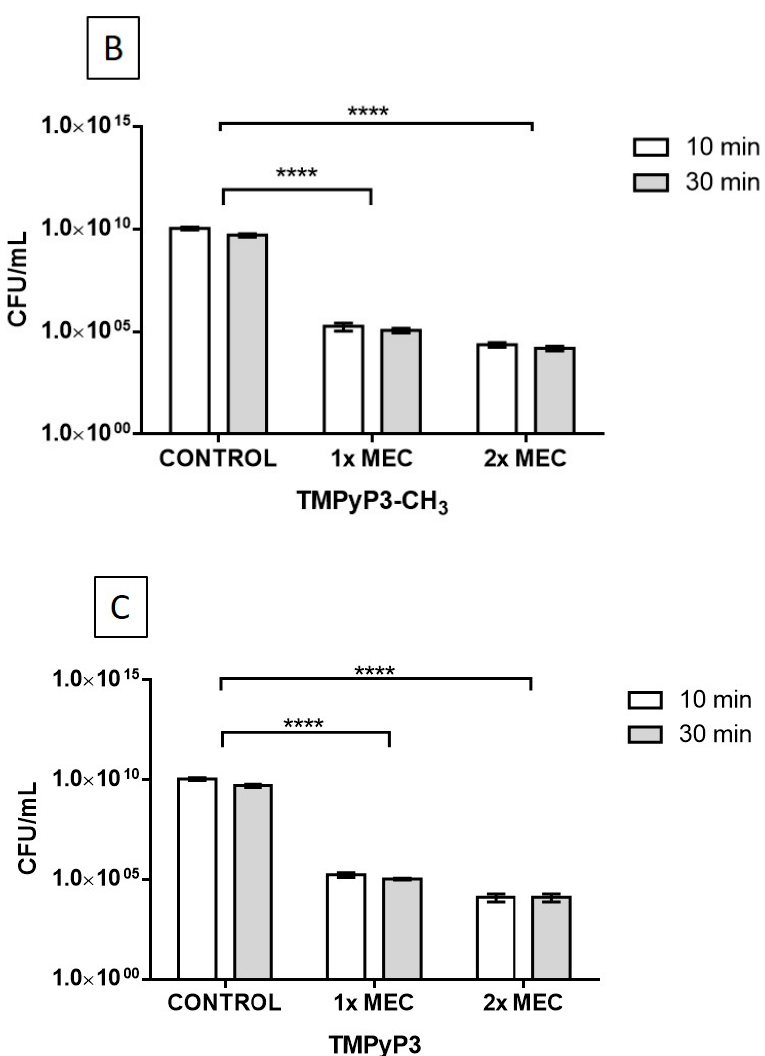
Figure 7. Co-cultivation of L. pneumophila and A. castellanii in the presence of 1 × MEC and 2 × MEC concentrations of PSs—porphyrins TMPyP3-C 17 H 35 ( A ), TMPyP3-CH 3 ( B ), TMPyP3 ( C ) without exposure to light. The control is the CFU / mLof L. pneumophila in the same conditions without PSs. Data are shown as an average of triplicate measurements and error bars represent SD; **** p < 0.0001.